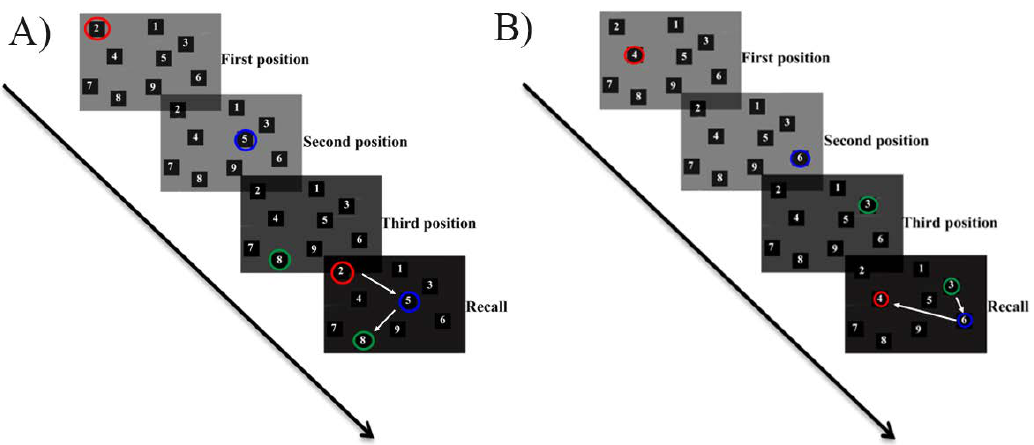
Figure 1. Spatial Span Test. Example of a trial representing a sequence length of three cubes. ( A ) Trial of the Spatial Span Test in the forward application; ( B ) Trial of the Spatial Span Test in the backward application. White arrows mark the correct order in which subjects should have remembered the tapping sequence.